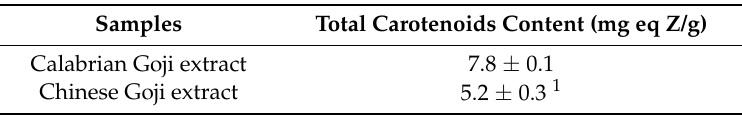
Table 1. Total Carotenoids expressed as milligram equivalents of Zeaxanthin per gram of extract (mg eq Z/g) in Calabrian and Chinese Goji